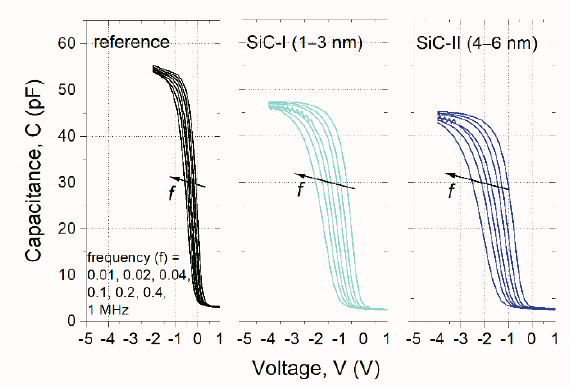
Figure 6. Obtained high-frequency families of C–V curves of examined in this work MIS structures; f = 0.01, 0.02, 0.04, 0.1, 0.2, 0.4, 1 MHz.